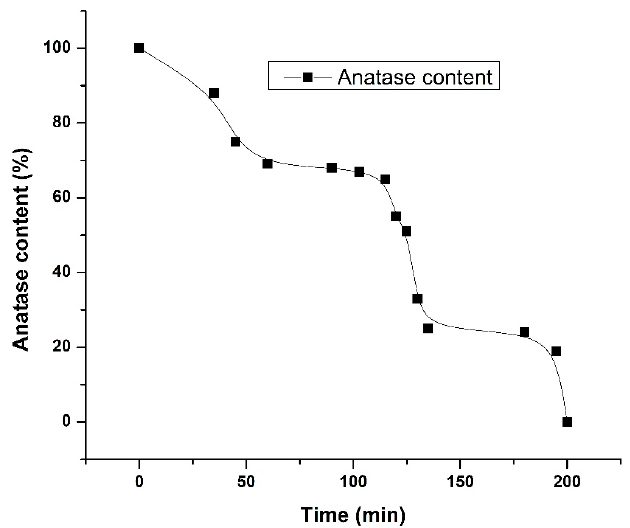
Figure 4. Anatase content as a function of annealing time for TiO 2 powders. Table 1. Phase content, optical bandgap, and particle size as a function of the annealing time.